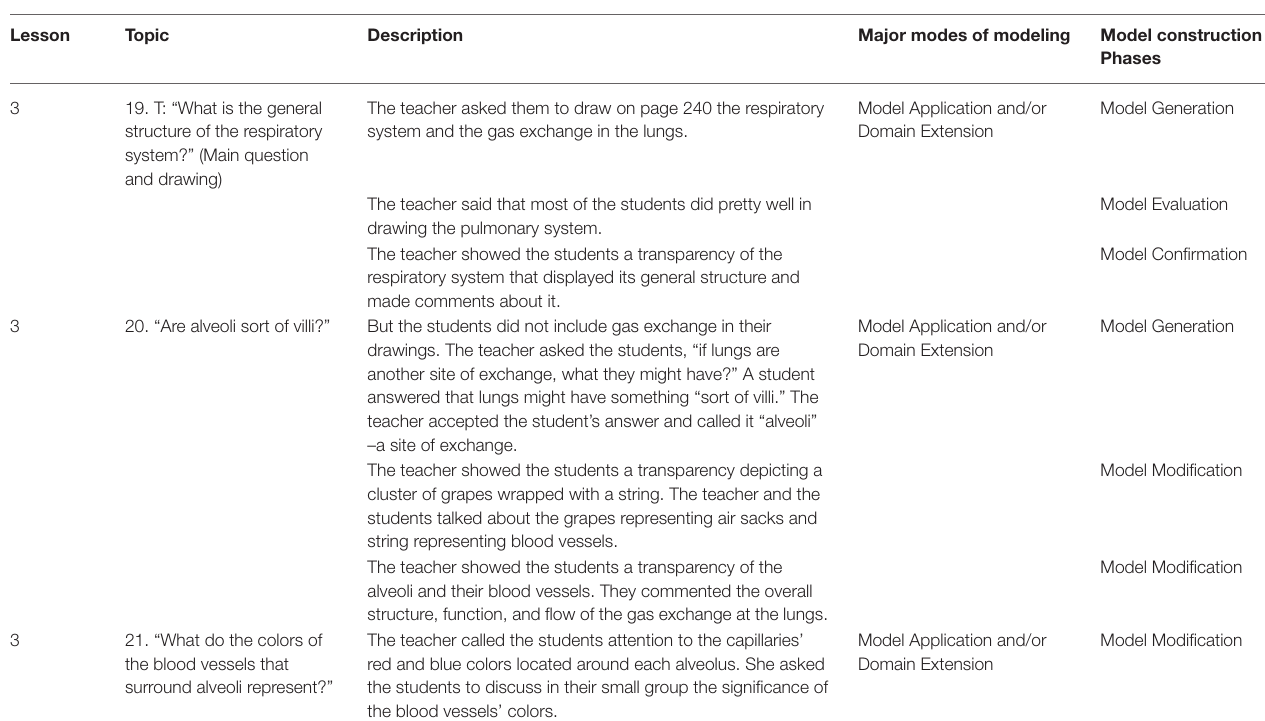
TABLE 8 | Model application and domain extension mode (part